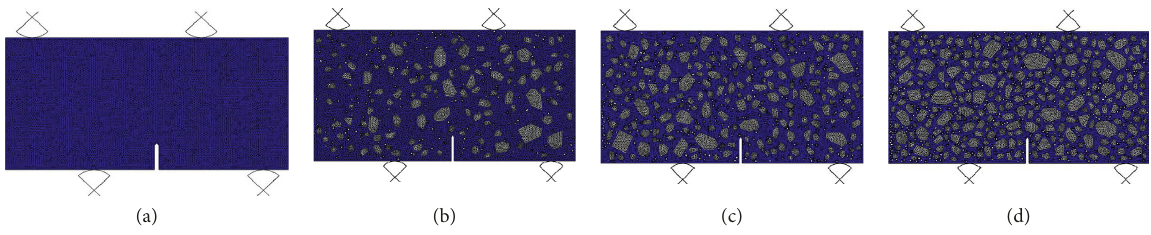
Figure 4: Model diagram of the volume rate of the coarse aggregate. (a) V